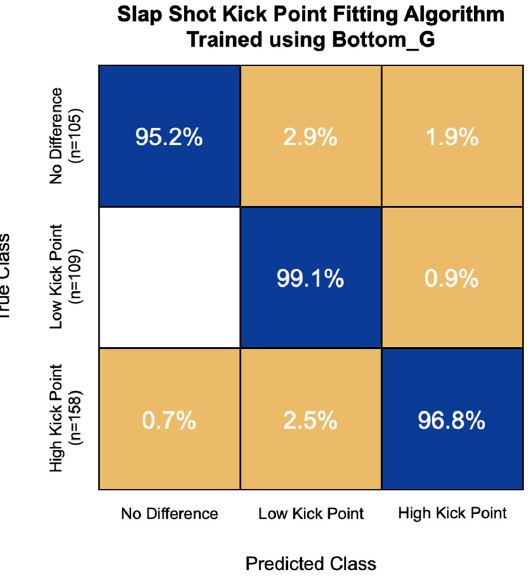
Figure 8. Confusion matrix of the kick point fitting algorithm for slap shot speed trained using bottom hand resultant angular velocity (Bottom_G) signal features. Overall model accuracy was 97.0%.